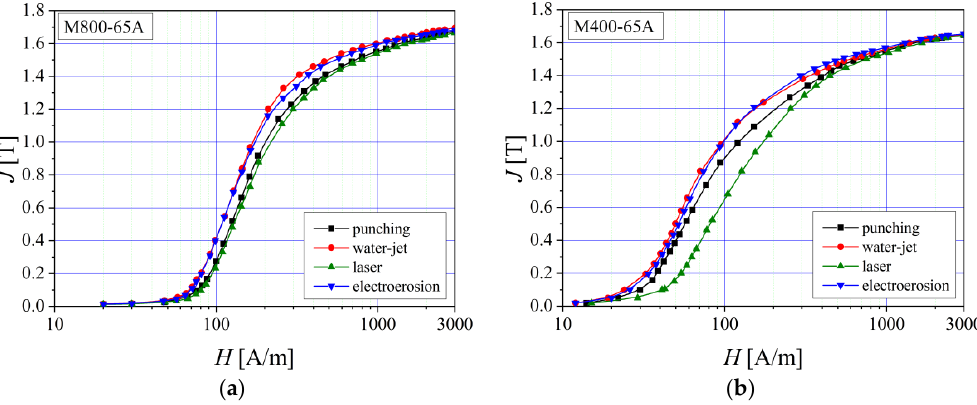
Figure 3. Normal magnetization curves measured at f = 2 Hz, in the case of ( a ) M800-65A and ( b ) M400-65A electrical steels.